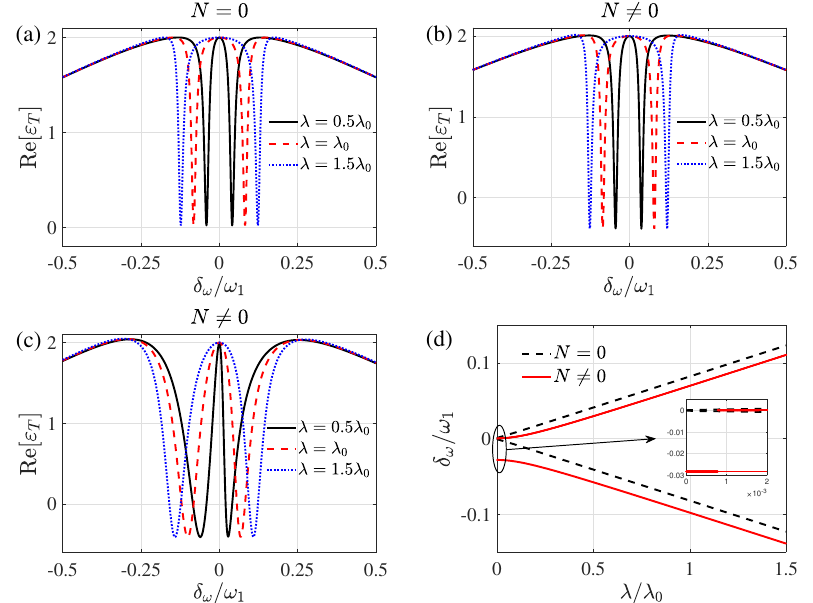
Figure 5. The absorption property Re[ ε T ] as a function of the normalized frequency δ ω / ω 1 for different Coulomb coupling strengths, where ( a ) P = 2 mW, N = 0, ( b ) P = 2 mW, N (cid:54) = 0, and ( c ) P = 10 mW, N (cid:54) = 0. ( d ) The positions of the two transparency dips as functions of the Coulomb coupling strength λ . The other parameters are the same as given in Figure